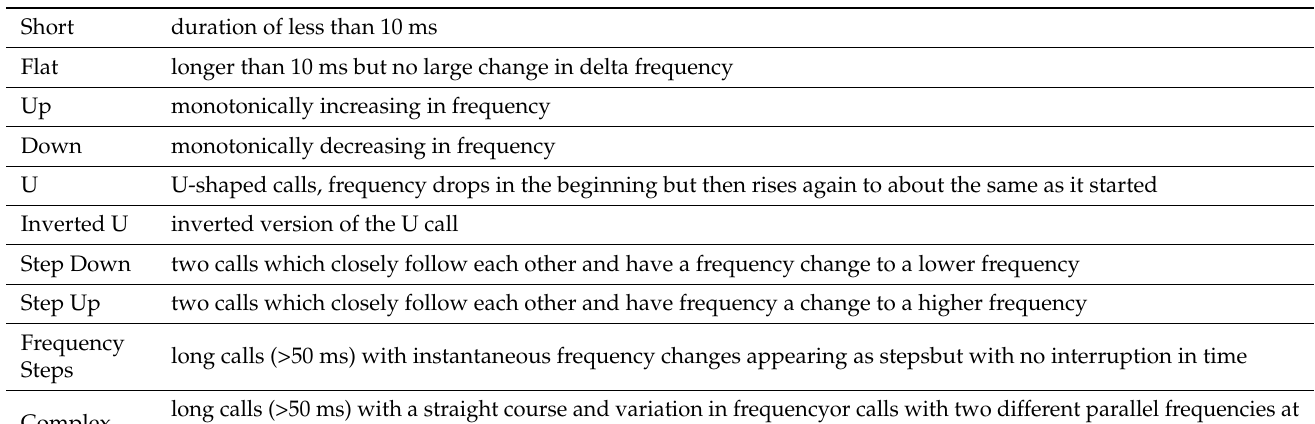
Table 1. List of all 10 different call classes and their main point of difference.